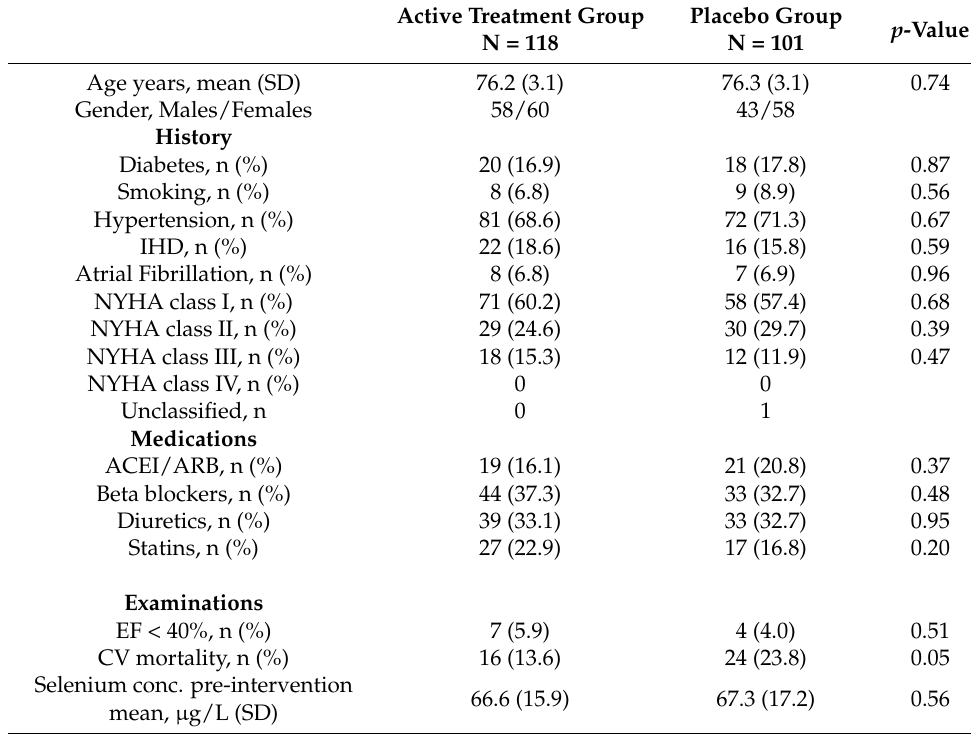
Table 1. Baseline characteristics of the study population receiving dietary supplementation of selenium and coenzyme Q 10 or placebo for a period of four